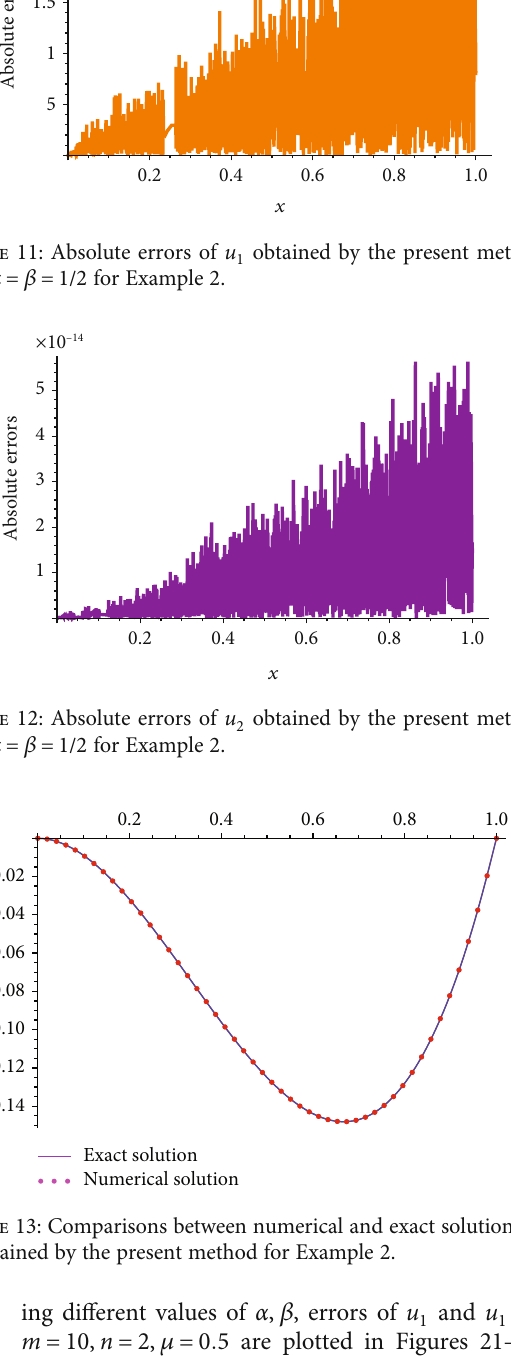
x Þ for Example 2. 1 ð